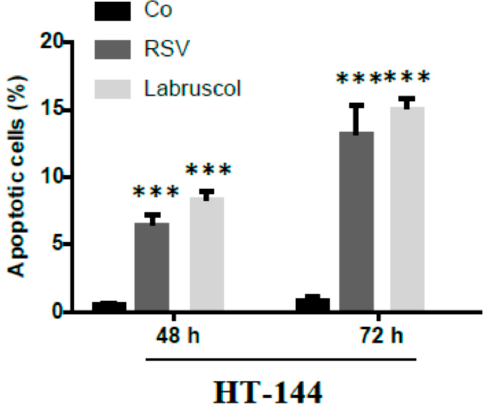
Figure 3. Apoptosis induction by resveratrol and labruscol in human skin melanoma cancer cells. Cells were treated during 48 h or 72 h with 50 μ M resveratrol or labruscol. Apoptosis was